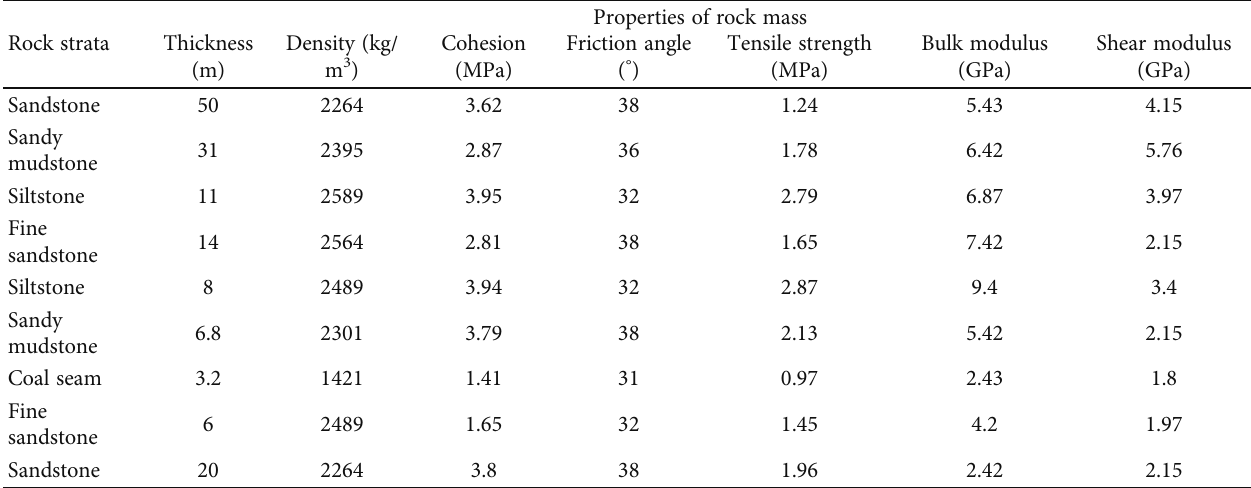
Figure 8: Sketch of the FLAC 3D mesh for the working face 14 – 1 105. Table 3: Rock strata properties used in the numerical